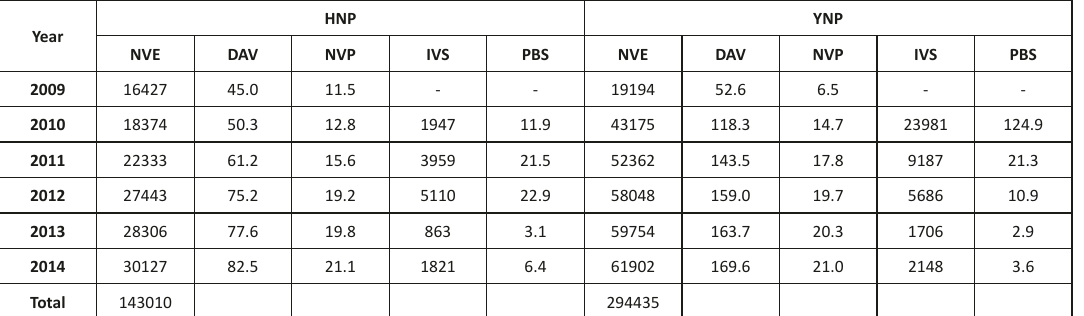
Table 2. Trends in entry of tourist vehicles into Horton Plains National Park (HNP) and Yala National Park (YNP) from 2009 to 2014 (abbreviations: NVE - Number of vehicles entered; DAV - Daily average number of vehicles entered; NVP - Number of vehicles as a percentage of total; IVS - Increment in number of vehicles between successive years; PBS - Percent increase between successive years).